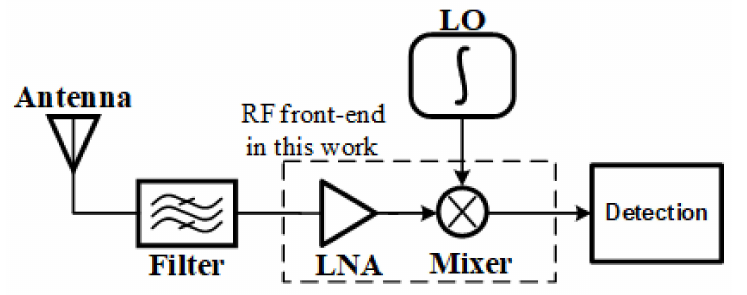
Figure 1. Simplified block diagram of DCR (direct conversion receiver).